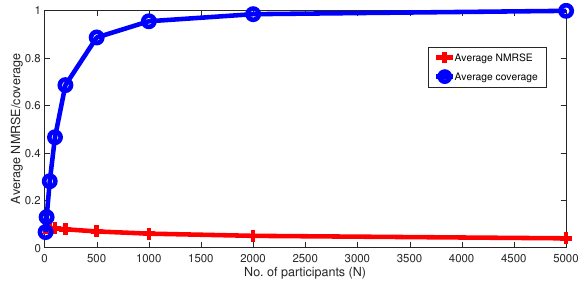
Figure 8: Average NRMSE and coverage for centralized - no privacy and various distributed spatial interpolation techniques